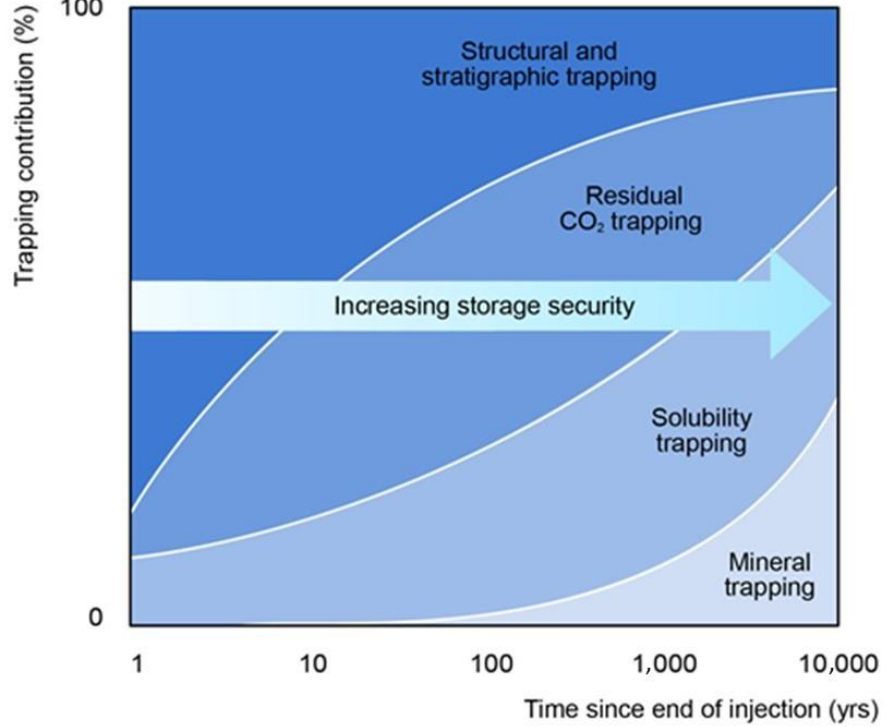
Figure 1. CO 2 trapping mechanisms: trapping times, contributions and storage security [18].